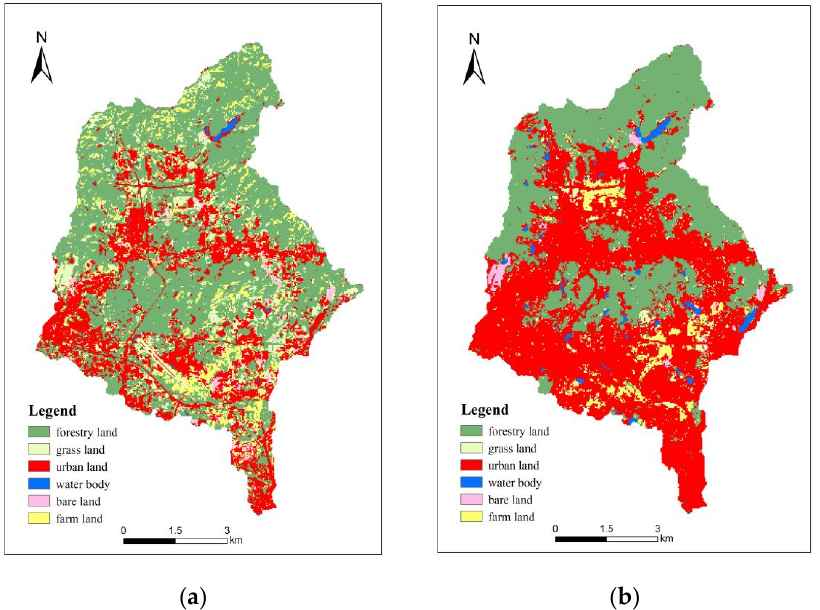
Figure 4. LUC types of the Chebei Creek watershed. ( a ) 2015 automated LUC; ( b ) 2015 corrected LUC.